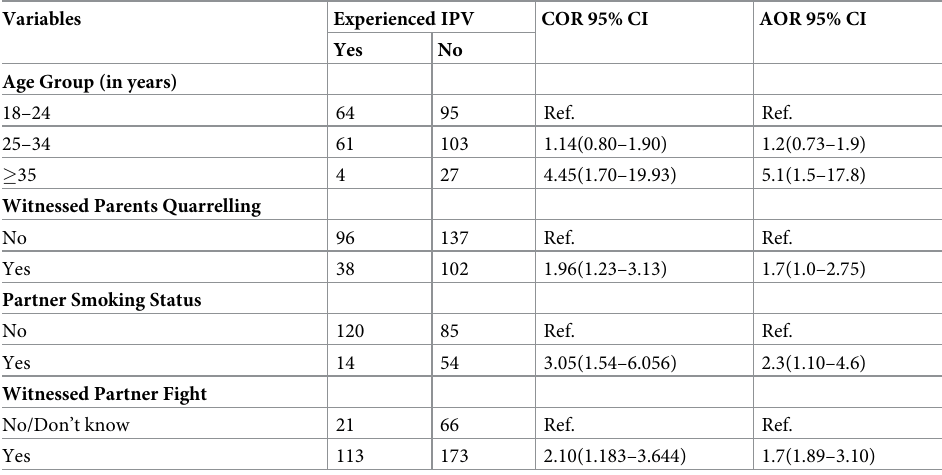
Table 5. Factors associated with IPV among pregnant women in rural Gambia,